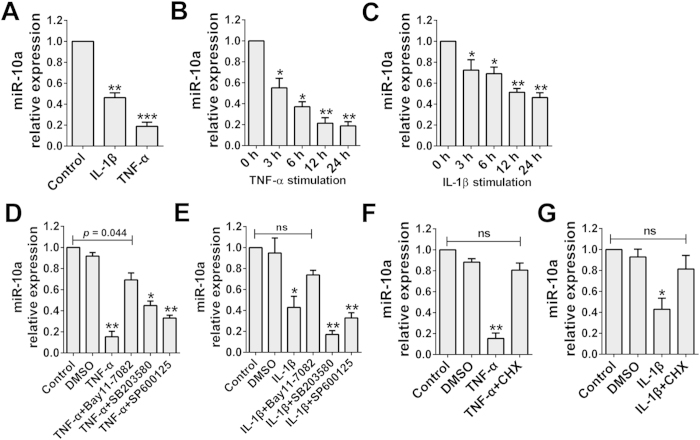
miR-10a is downregulated by TNF-α and IL-1β in an NF-κB-dependent manner.(A) RA FLSs (n = 3 samples) were stimulated with TNF-α or IL-1β (10 ng/ml) for 24 h, and the miR-10a expression level was analyzed through real-time PCR. U6B was used as the negative control. (B) RA FLSs (n = 3 samples) were treated with TNF-α for the indicated period, and the miR-10a expression level was detected via real-time PCR. (C) Cells were treated with IL-1β, and miR-10a was detected as shown in (B). (D) Cells were treated with TNF-α either alone or in the presence of inhibitors of NF-κB (Bay 11-7082), JNK (SP600125) or p38MAPK (SB203580), and miR-10a was detected 24 h later. (E) The same method was applied as in (D), except that TNF-α was replaced by IL-1β. (F) TNF-α-stimulated cells were pretreated with CHX, and the miR-10a expression level was analyzed 24 h later through real-time PCR. (G) The same method was applied as in (F), except that TNF-α was replaced with IL-1β. *P < 0.05, **P  < 0.01 or ***P < 0.001 compared with the control group. Data are representative of three experiments.